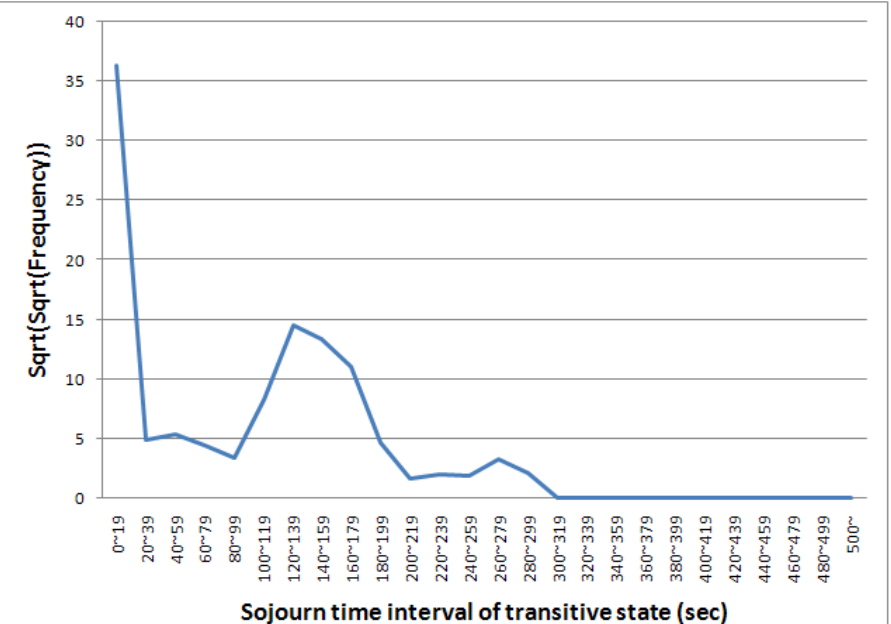
Figure 6. An example of the frequency transformation with δ =